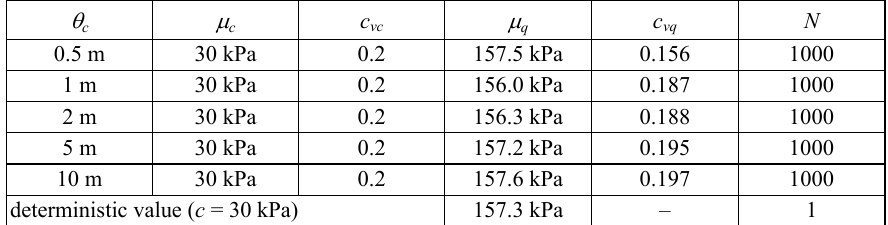
Table 2. Results of random analysis for frictionless soil obtained for different scales of